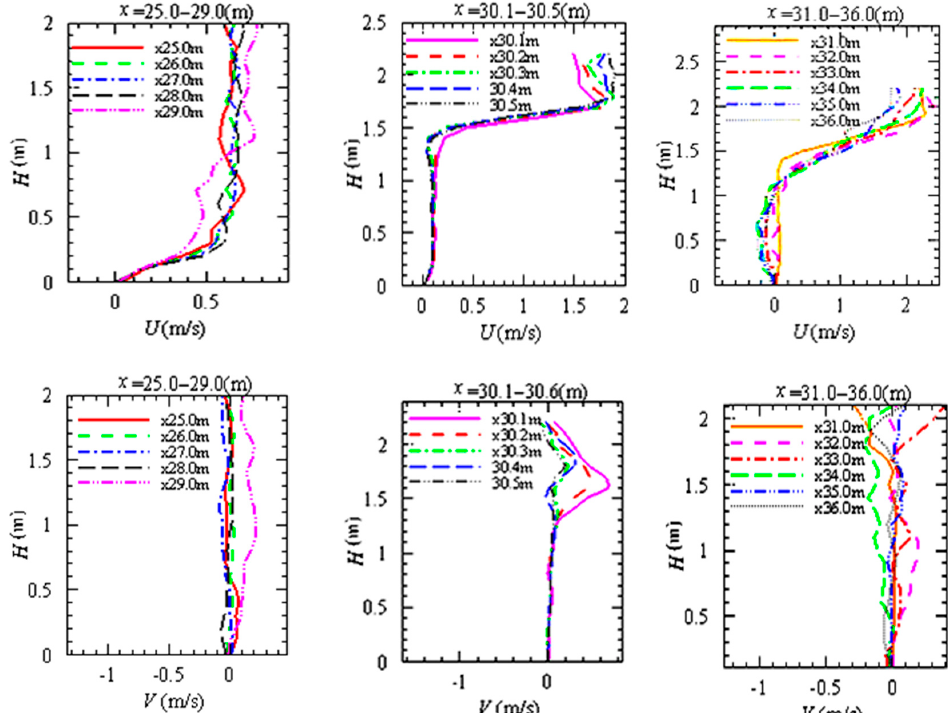
Figure 14. Characteristics of longitudinal and vertical flow fields when the longitudinal section of the pore is 1.5 m × 1.5 m; solid line: x = 25.0; x = 30.1 x = 31.0; dashed line: x = 26.0; x = 30.2 x = 32.0; dotted pore is 1.5 m × 1.5 m; solid line: x = 25.0; x = 30.1; x = 31.0; dashed line: x = 26.0; x = 30.2; x = 32.0; line: x = 27.0; x = 30.3x = 33.0. Long dashed line: x = 28.0; x = 30.4 x = 34.0; double dotted line: x = 29.0; dotted line: x = 27.0; x = 30.3; x = 33.0. Long dashed line: x = 28.0; x = 30.4; x = 34.0; double dotted line: x = 30.5 x = 35.0; dotted line: x = 36.0. x = 29.0; x = 30.5; x = 35.0; dotted line: x =